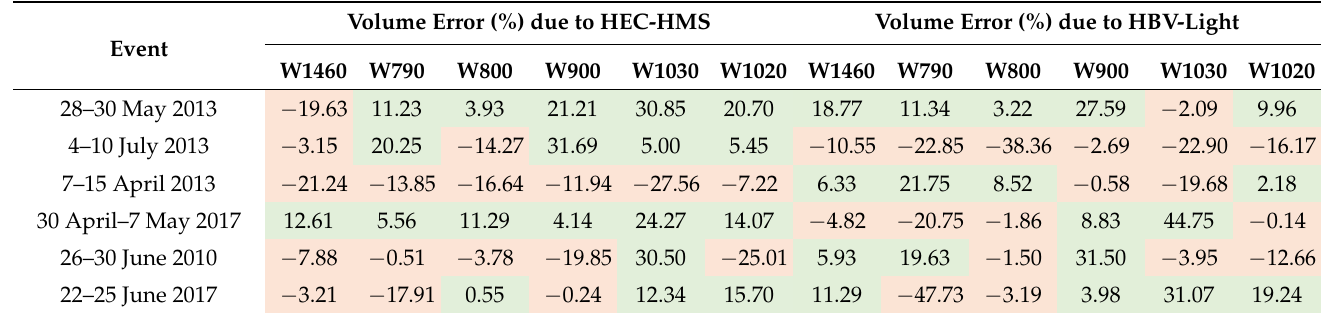
Table 16. Volume error per sub-basin for the studied precipitation